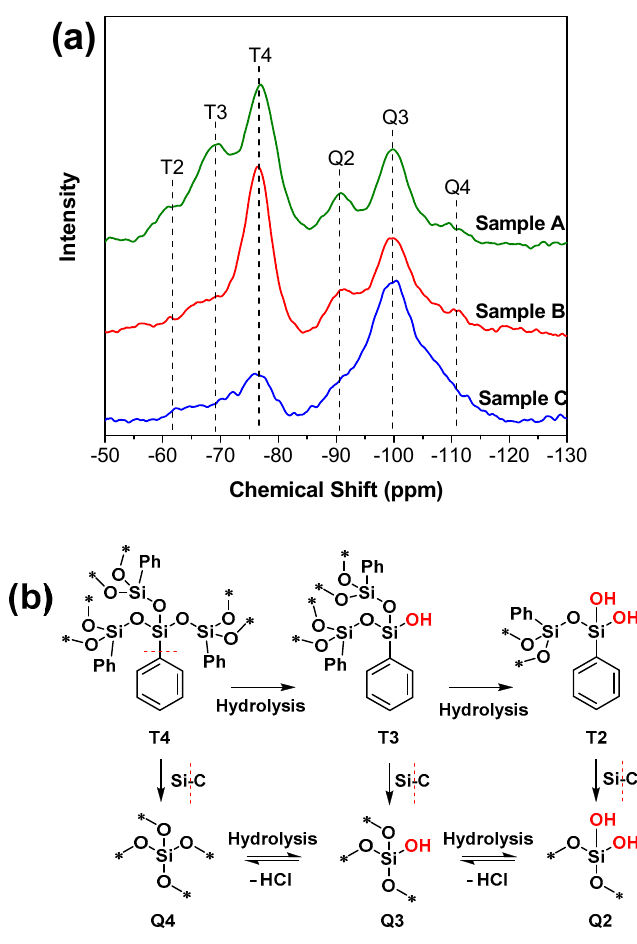
Figure 4. ( a ) Solid 29 Si NMR of sample A, sample B, and sample C, and ( b ) the typical structures of the T-group and Q-group.